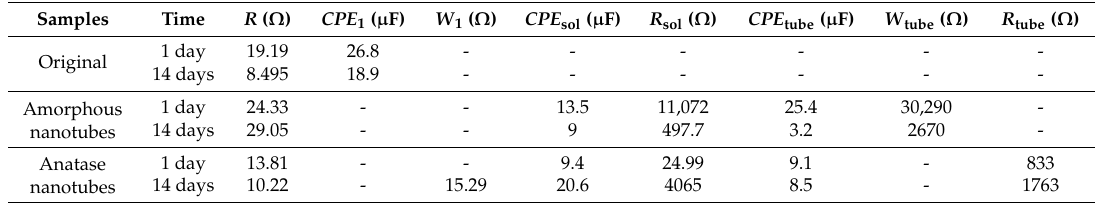
Table 2. Values of equivalent circuits obtained by Wen [27].